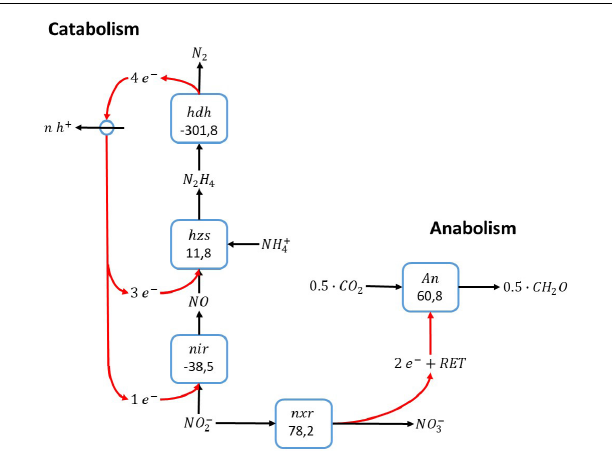
FIGURE 1 | Anammox reaction stoichiometry, assuming ammonium activation with nitric oxide (Kartal et al., 2011). The individual blocks represent enzymatic steps ( hdh , hydrazine dehydrogenase; nir , nitrite reductase; hzs , hydrazine synthase; nxr , nitrite oxidoreductase) and the corresponding Gibbs free energy change ( (cid:52) G 0 (cid:48) ) of the reaction corrected for a pH of 7. RET stands for reversed electron